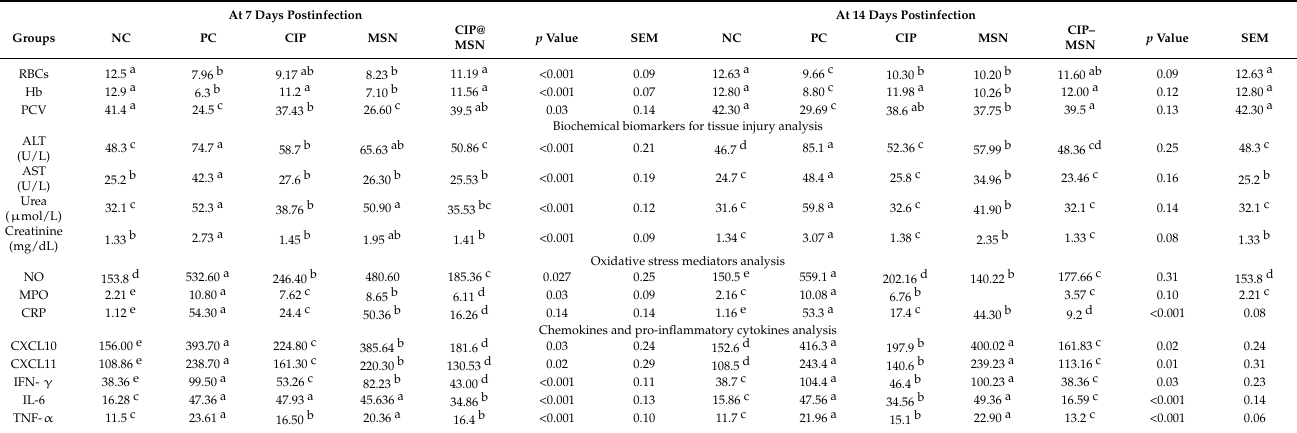
Table 2. Effects of MSN particles loaded with ciprofloxacin compared with ciprofloxacin on hemato- logical, biochemical, and oxidative stress mediators and the immunological parameters of male rats (7 and 14 days postchallenge with Salmonella typhimurium